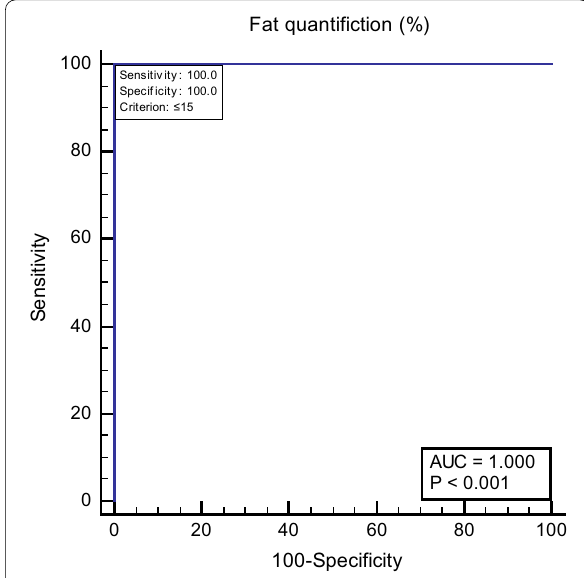
Fig. 5 ROC curve for in-phase/opposed-phase ratio to discriminate malignant from benign